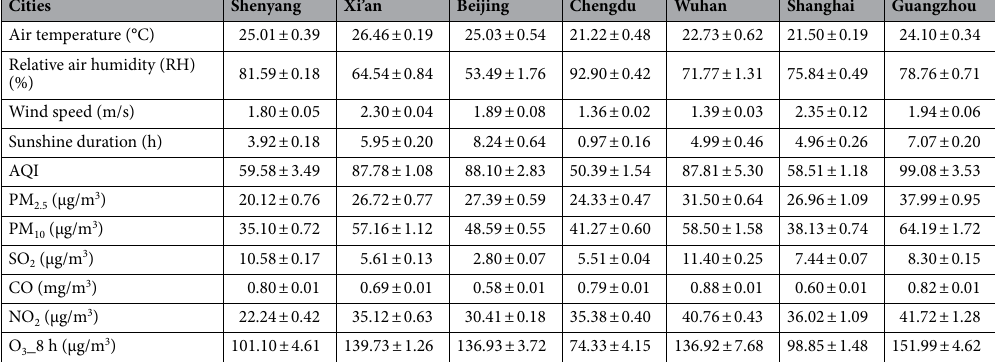
Table 3. Descriptive analysis of normal environmental factors and air pollutants data in various cities (X ± SD).